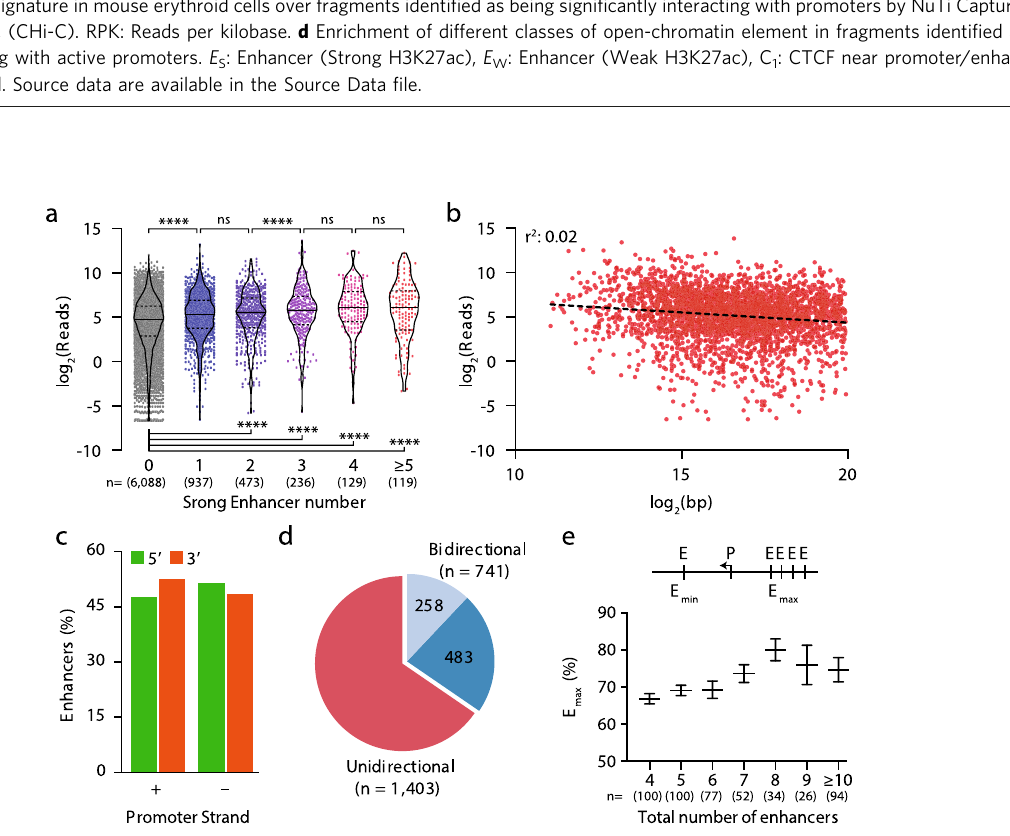
Fig. 4 Comparison of capture resolution at the Nfe2l1 and Pnpo promoters. a Sequence tracks showing the difference between high-resolution 3C ( Dpn II, NuTi Capture-C) and low-resolution 3C ( Hind III, Capture Hi-C) from nearby gene promoters (mm9, chr11:96,572,876-96,883,917) in erythroid cells. Tracks in order: UCSC gene annotation, cis -normalized mean interactions per Dpn II fragment using NuTi Capture-C ( n = 3 independent 3C libraries), NuTi Capture-C viewpoints, peaky Marginal Posterior Probability of Contact (MPPC) scores with fragments with MPPC ≥ 0.01 darker, GenoSTAN open- chromatin classi fi cation, windowed mean interactions using NuTi Capture-C, total supporting reads per Hind III fragment with CHi-C ( n = 2; co-targeted fragments are lighter in color), CHi-C bait fragments, loops between reported signi fi cantly interacting fragments (co-targeting loops are colored gray), erythroid tracks for open chromatin (DNaseI). Note overlapping blue and red signals appear darker in color (NuTi Capture-C, peaky MPPC, CHi-C). b Number of interacting promoters identi fi ed as present in promoter-hubs. **** p < 0.0001 a two-sided Mann – Whitney U -test. For NuTi n = 4339 promoter viewpoints, and for CHi-C n = 19,683 promoter viewpoints. Box and Whiskers show: minima 25th percentile, median, 75th percentile and maxima. c Average chromatin signature in mouse erythroid cells over fragments identi fi ed as being signi fi cantly interacting with promoters by NuTi Capture-C (Nu- 3C) and Capture Hi-C (CHi-C). RPK: Reads per kilobase. d Enrichment of different classes of open-chromatin element in fragments identi fi ed as being signi fi cantly interacting with active promoters. E S : Enhancer (Strong H3K27ac), E W : Enhancer (Weak H3K27ac), C 1 : CTCF near promoter/enhancer, C 2 :